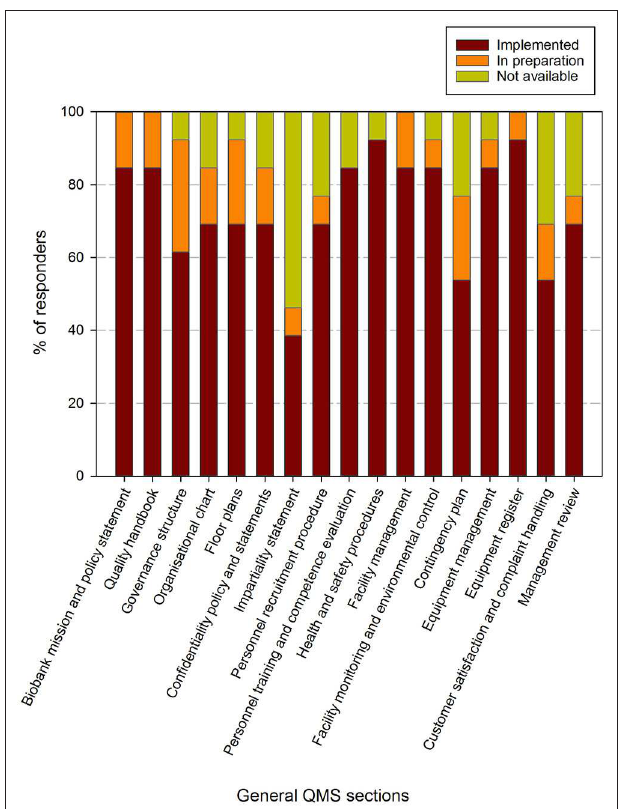
FIGURE 4 | Implementation status of general procedures in the quality management system in biobanks in the BBMRI.be network. Participants were requested to indicate for each item in a list of general procedures/items whether these were fully implemented (brown), in preparation (orange) or not available (lime-green). The items listed were collected and aggregated from the ISBER best practices for biorepositories, the ISO 20387 and ISO 9001 standards. All participants responded to all items listed. The list of items asked is displayed in the